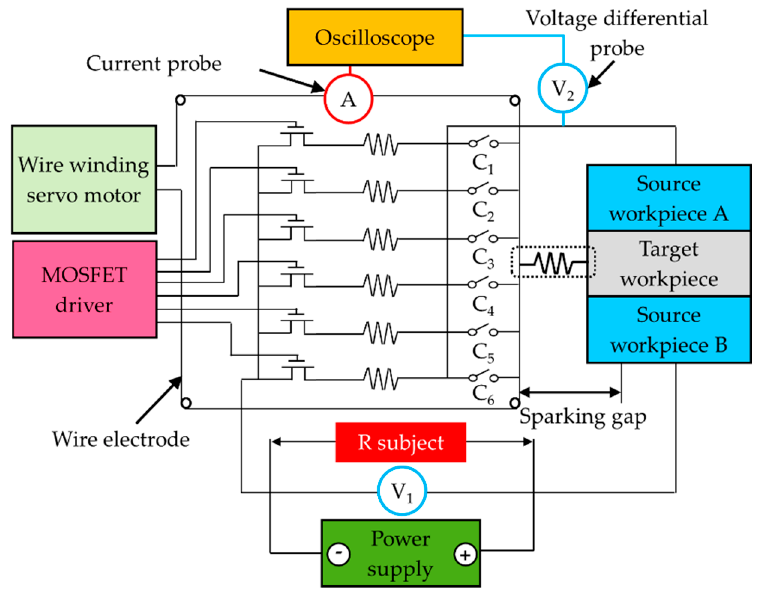
Figure 4. Designed integrated circuit modified to use MOSFET for high-power bipolar switching driver.